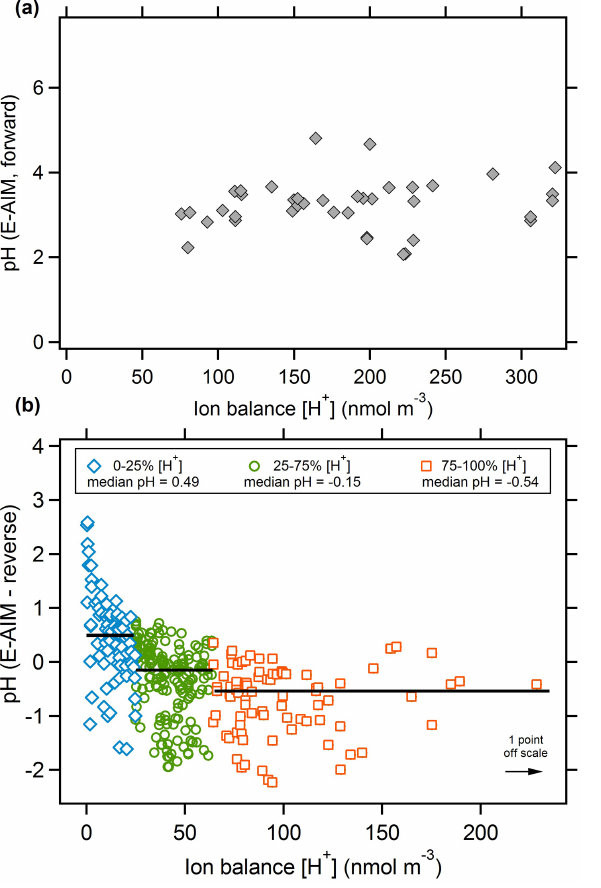
Figure 6. (a) Aerosol pH predicted by E-AIM in the forward mode vs. the H + concentration derived from the ion balance, and (b) aerosol pH predicted by E-AIM in the reverse mode vs. the H + con- centration derived from the ion balance. Only points with a cation charge deficit ( (cid:54) (anions)> (cid:54) (cations)) are included in the analysis in (b) . The horizontal black bars in (b) represent the medians corre- sponding to the values in the